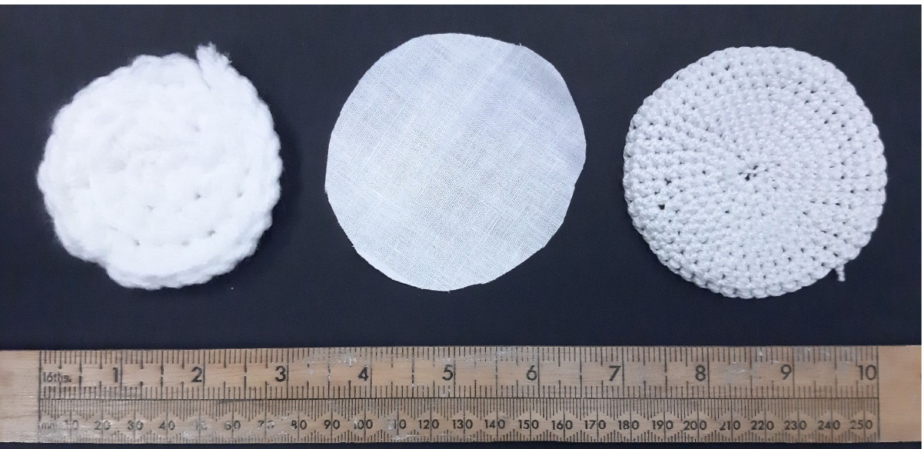
Figure 1. Image of discs wool ( left ), linen ( center ) and cotton ( right ) fibers before staining and dyeing